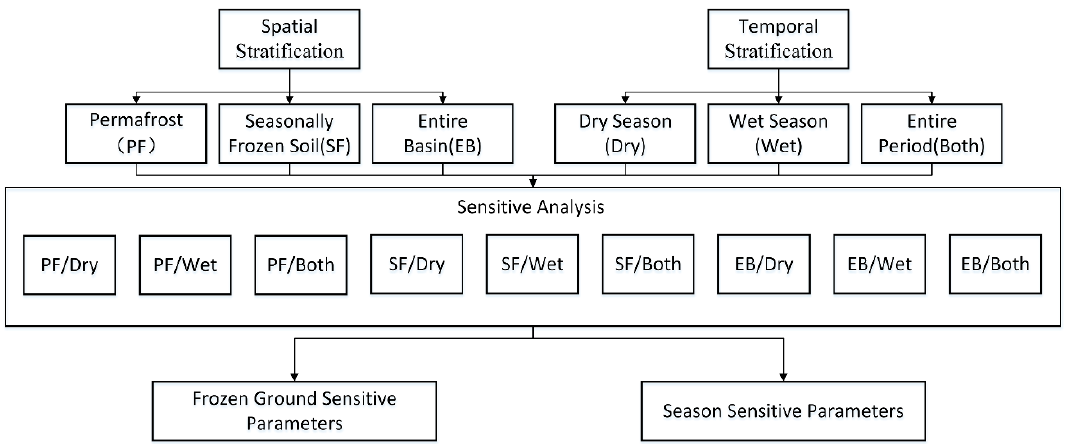
Figure 1. Workflow to identify the distributed hydrology–soil–vegetation model (DHSVM) parameters sensitive to frozen ground types and to seasons.